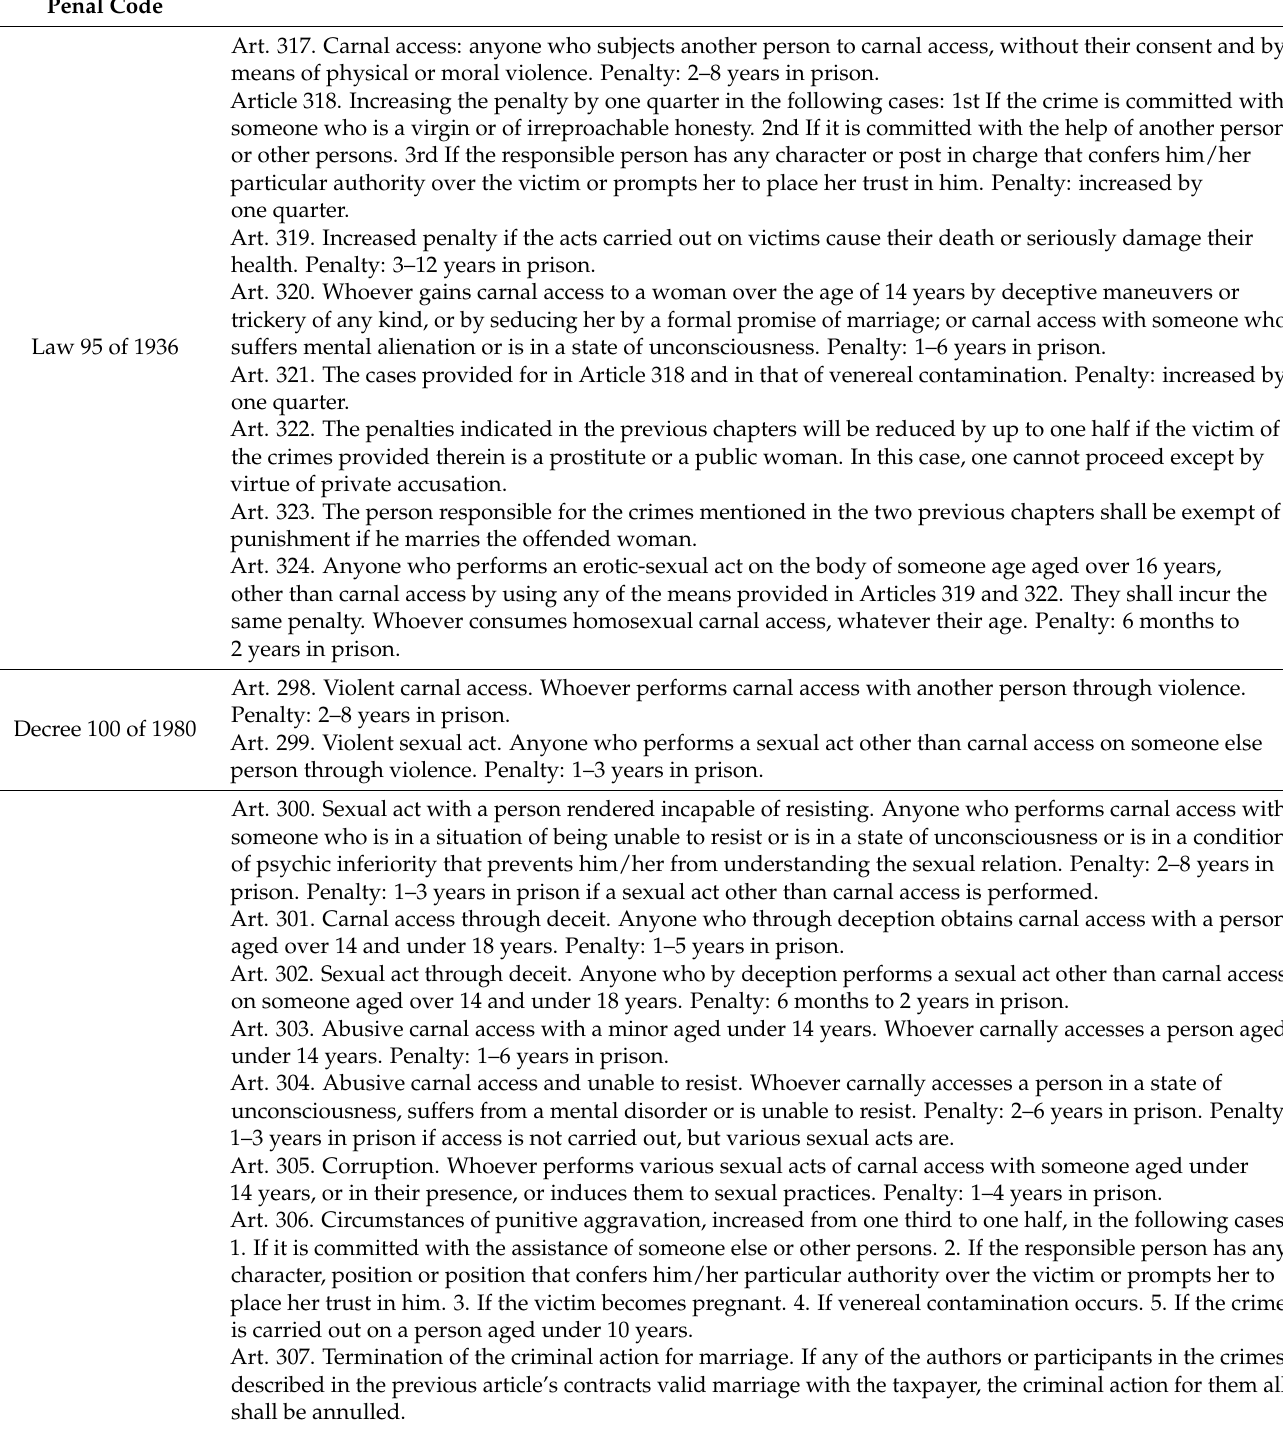
Table 2. Punitive evolution of sexual